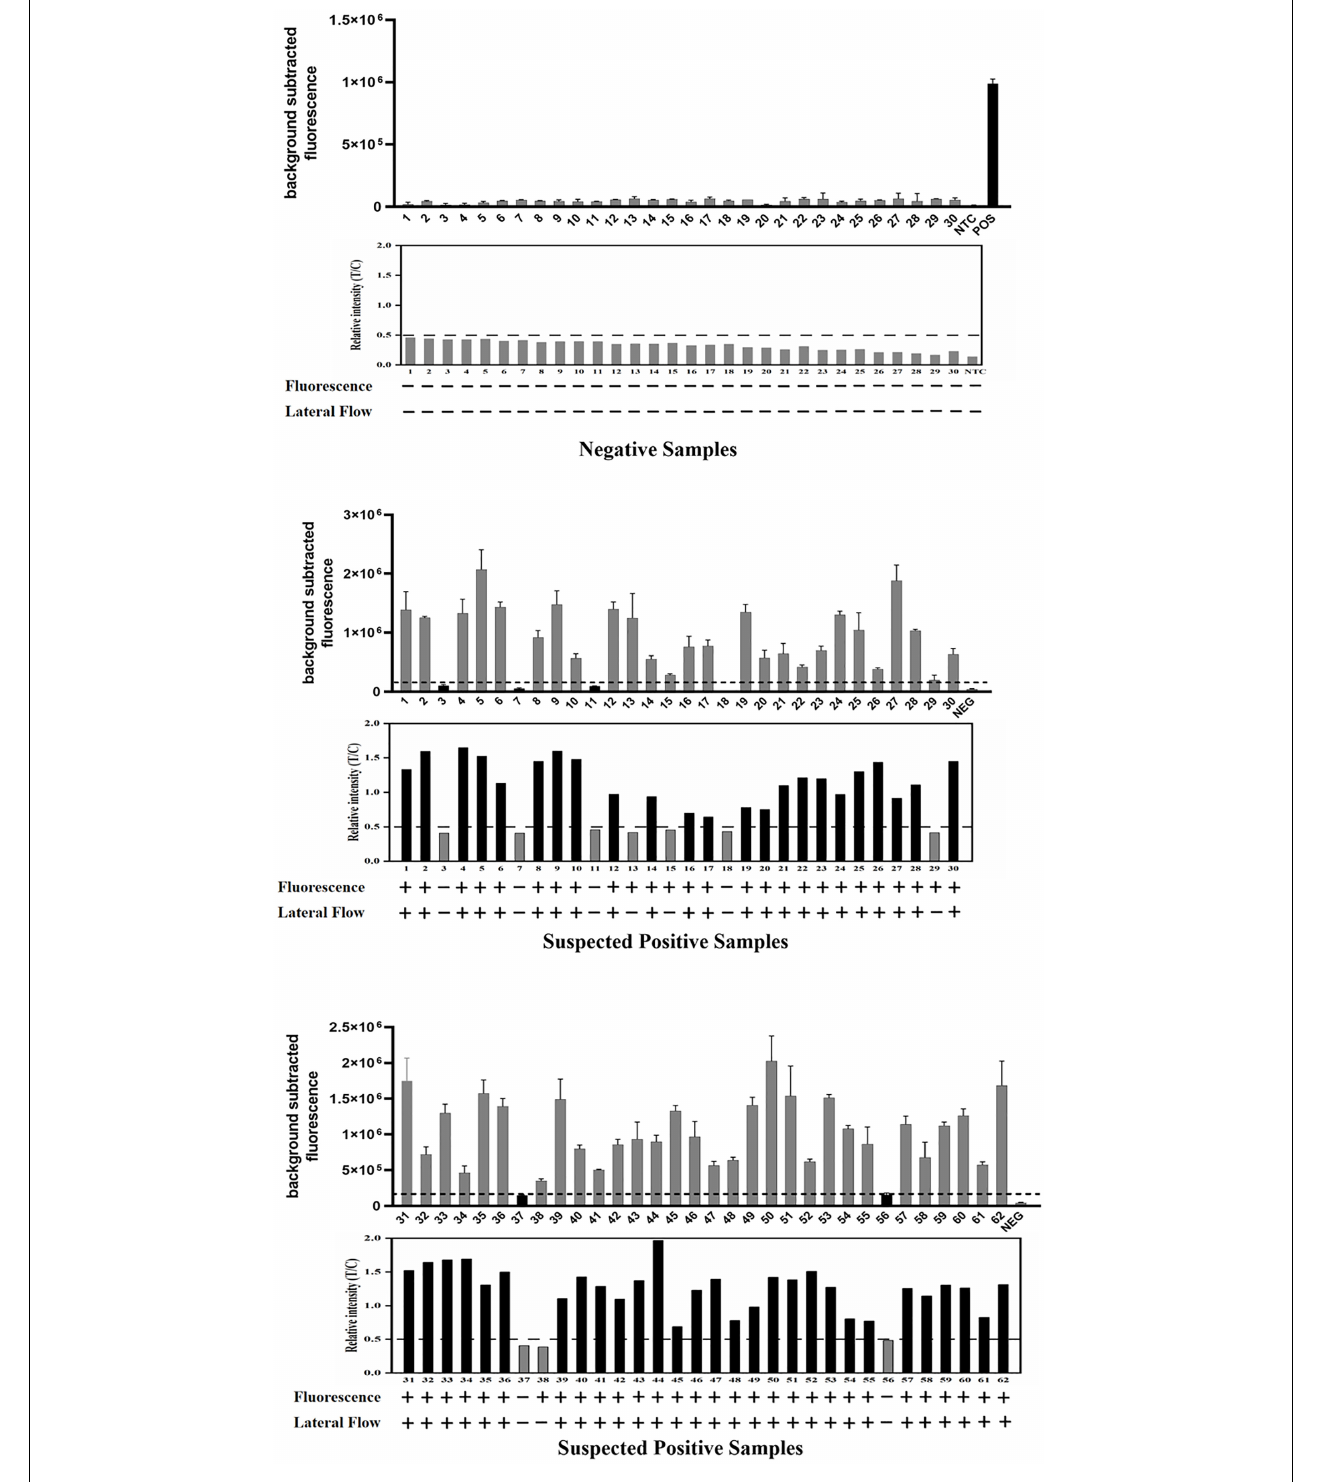
FIGURE 7 | Detection of 92 clinical samples by the ERA/CRISPR–Cas12a dual system for M. pneumoniae . For each group of results, the detection results of the ERA/CRISPR–Cas12a fluorescence system are displayed at the top, the gray scan results of the strips are displayed in the middle, and the bottom is the interpretation results of the dual system. Background subtracted fluorescence was the fluorescence intensity of the experimental group against the blank control. Black horizontal dashed line indicates the threshold for a positive result. + : indicates a positive sample, − : indicates a negative sample. Error bars in panels represent the mean ± SD, where n = 3